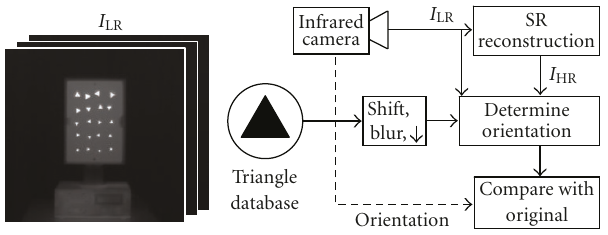
Figure 4: Left: example of real-world data I LR . Right: flow diagram of the real-world data experiment.